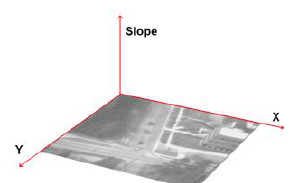
Figure ４ : (slope, x, y) Vector